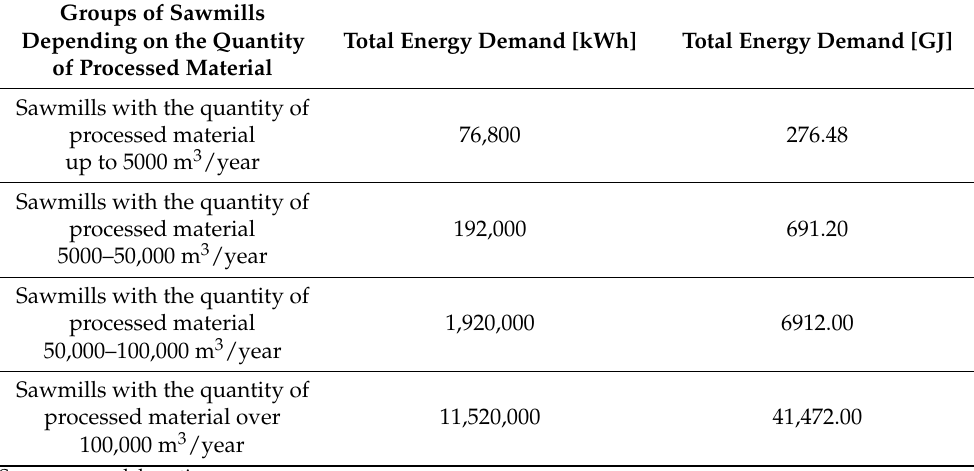
Table 10. Total energy demand of each group of